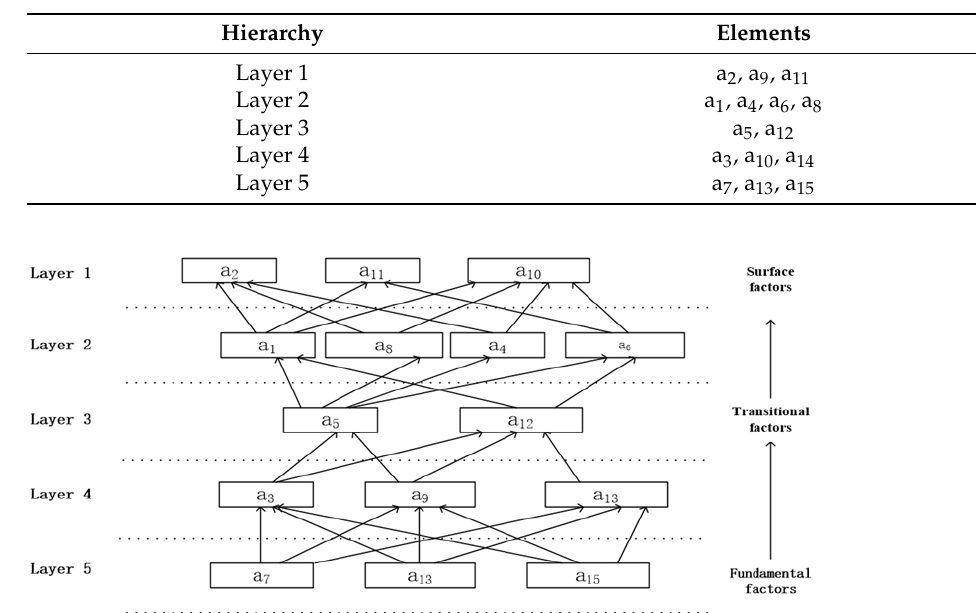
Table 6. Hierarchical decomposition diagram.